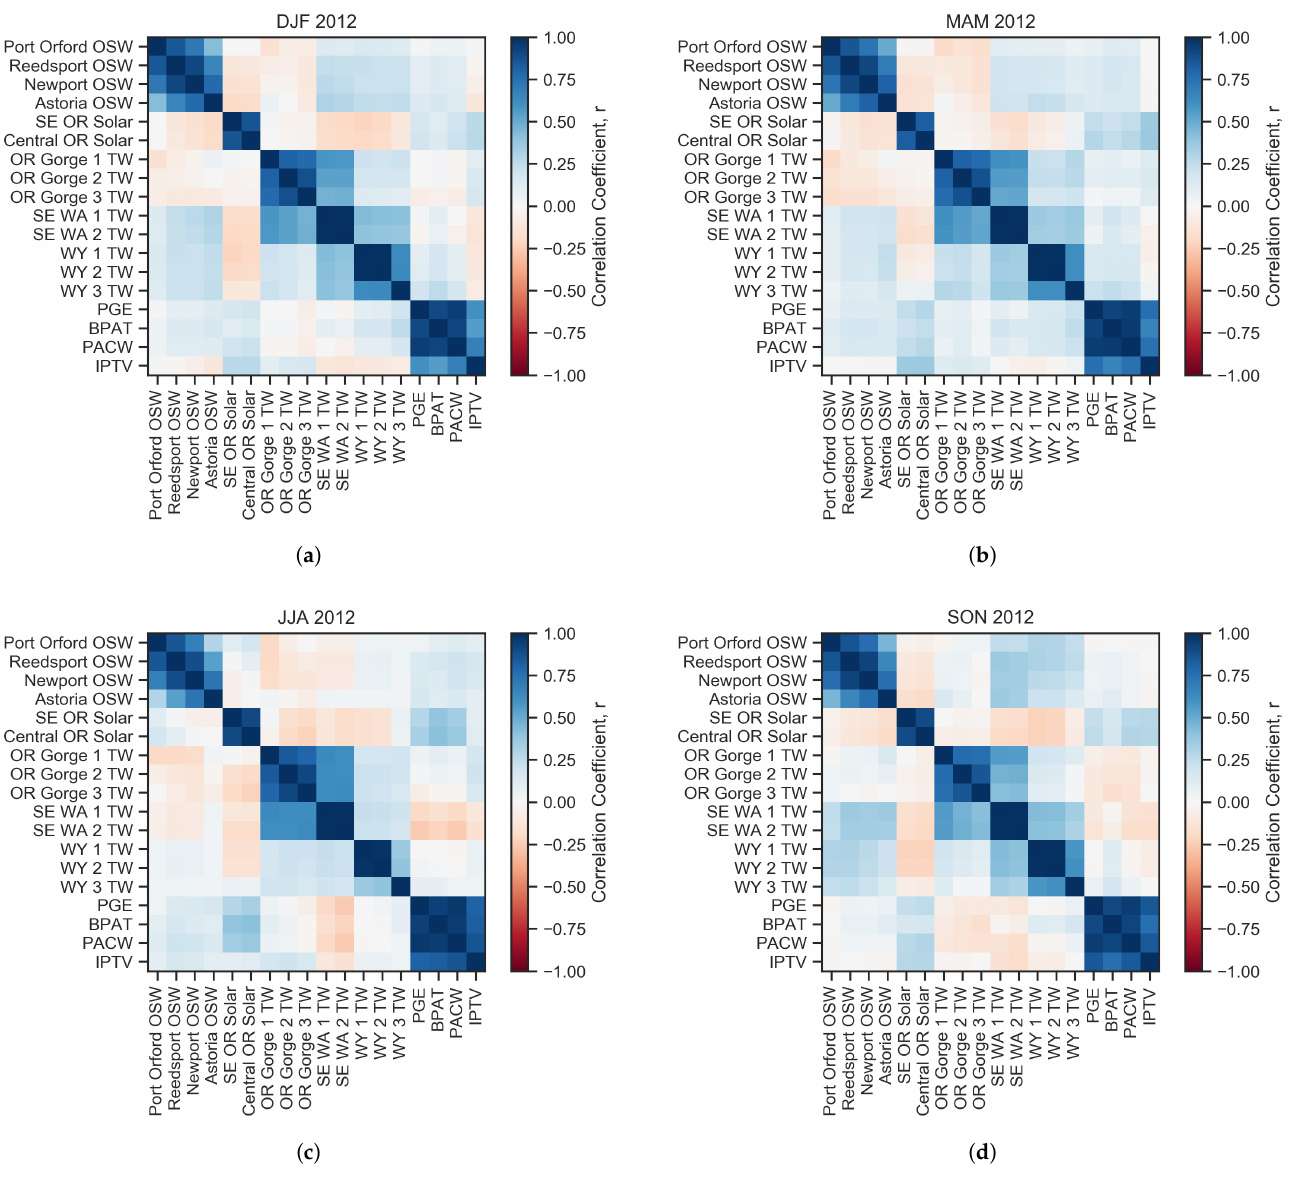
Figure 7. Seasonal load and resource complementarity in 2012: ( a ) December, January, February (DJF); ( b ) March, April, May (MAM); ( c ) June, July, August (JJA); and ( d ) September, October, November (SON). Blue colors indicate desirable correlations with